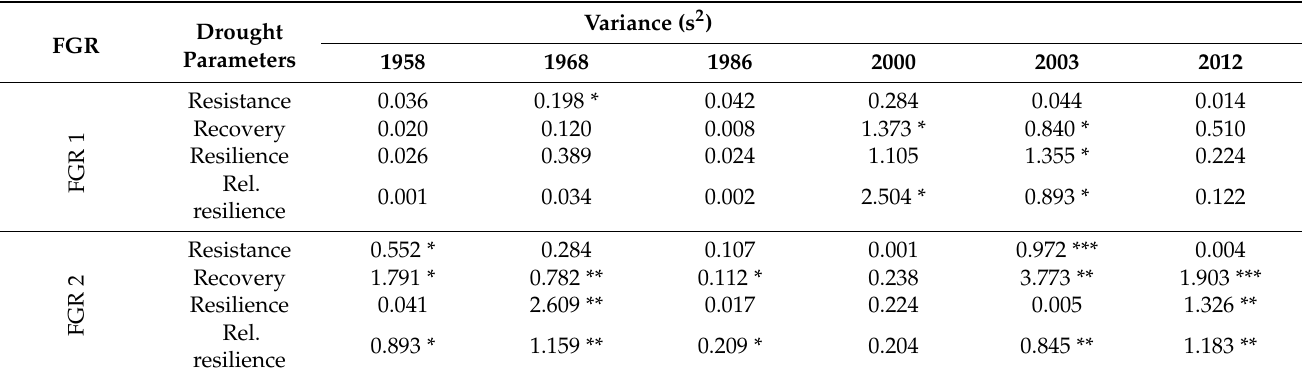
Table 5. Differences between Douglas fir and Norway spruce for the drought parameters during the years of extreme